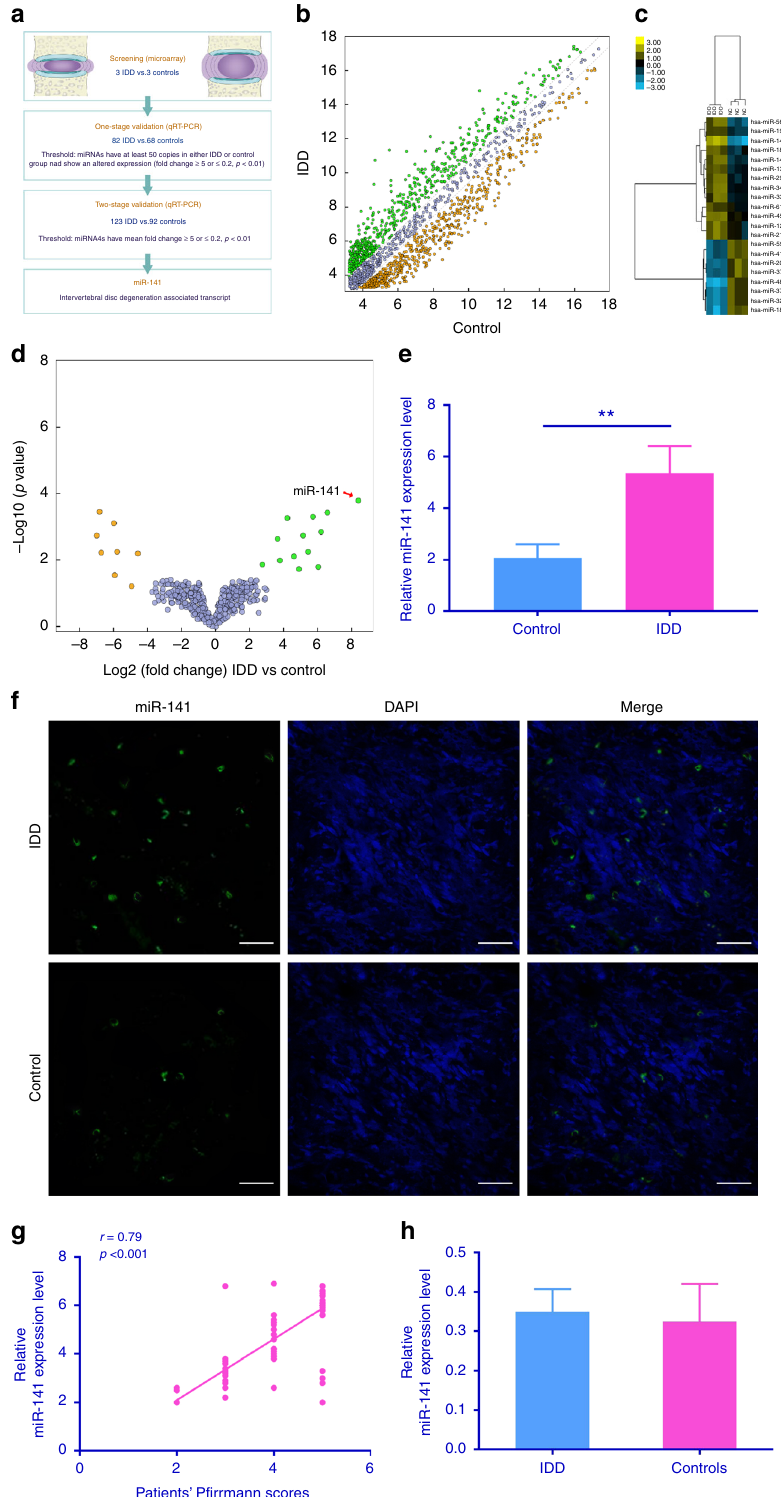
in the pathogenesis of IDD, we transiently transfected miR-141 mimics or inhibitor into cultured primary human NP cells. Transfection ef fi ciency was detected by Cy3-labeled miRNA (Fig. 3a), which was further con fi rmed by qRT-PCR (Fig. 3b). Our analysis indicated that miR-141 overexpression dominantly decreased cell proliferation compared with its